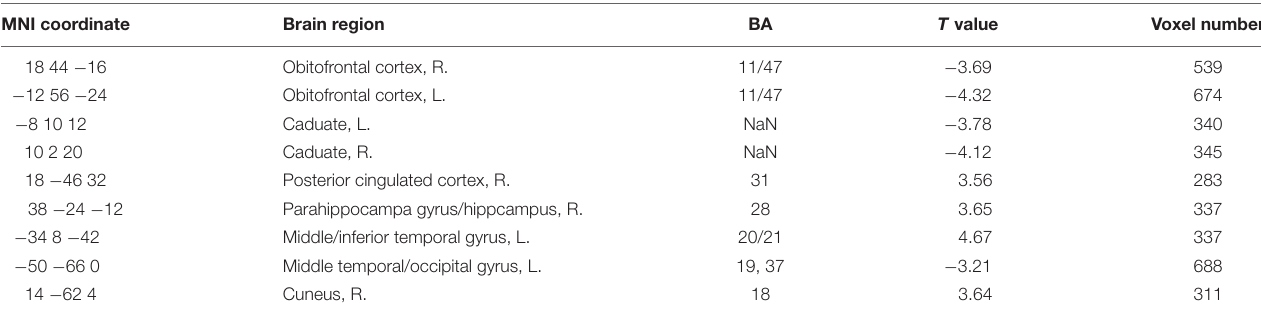
TABLE 3 | Regions showing significantly different connectivity with right GPi in TS patients as compared to controls. MNI coordinate Brain region BA T value 18 44 − 16 Obitofrontal cortex, R.